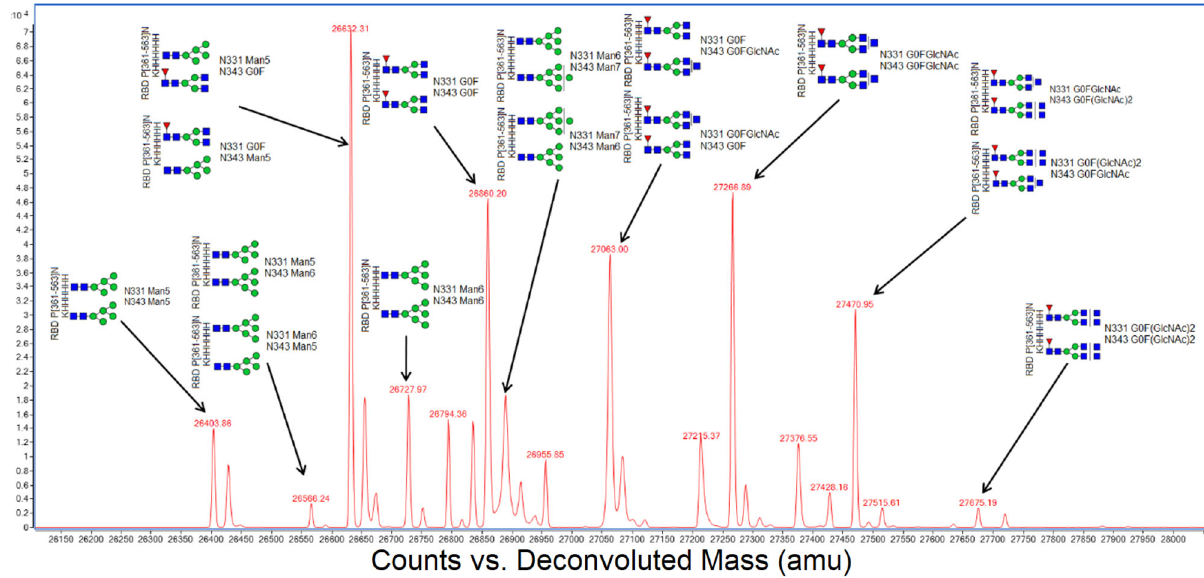
Fig. 4 Intact mass analysis of RBD protein. Labels indicate the principal glycan species Man5, G0F, and G0F + GlcNAc occurring at sequence positions N331 and N343, which are in agreement with glycopeptide analysis. Note that this method cannot differentiate individual glycosylation sites; hence, when two structures are possible, both are